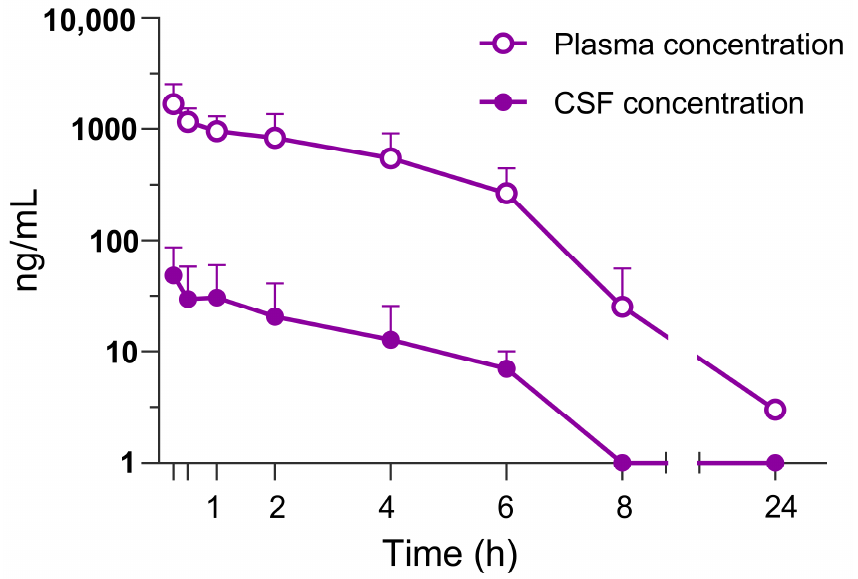
Figure 1. Plasma and CSF concentrations of dipraglurant after oral administration of 10 mg/kg of the compound administered at 3 mL/kg in water. Sprague-Dawley rats ( n = 5) were used to collect blood via jugular vein catheter for standard plasma preparation at 0.25, 0.5, 1, 2, 4, 6, 8 and 24 h. Simultaneously, 8 CSF samples were collected at the same time points. Each point represents the measured mean ± SD.